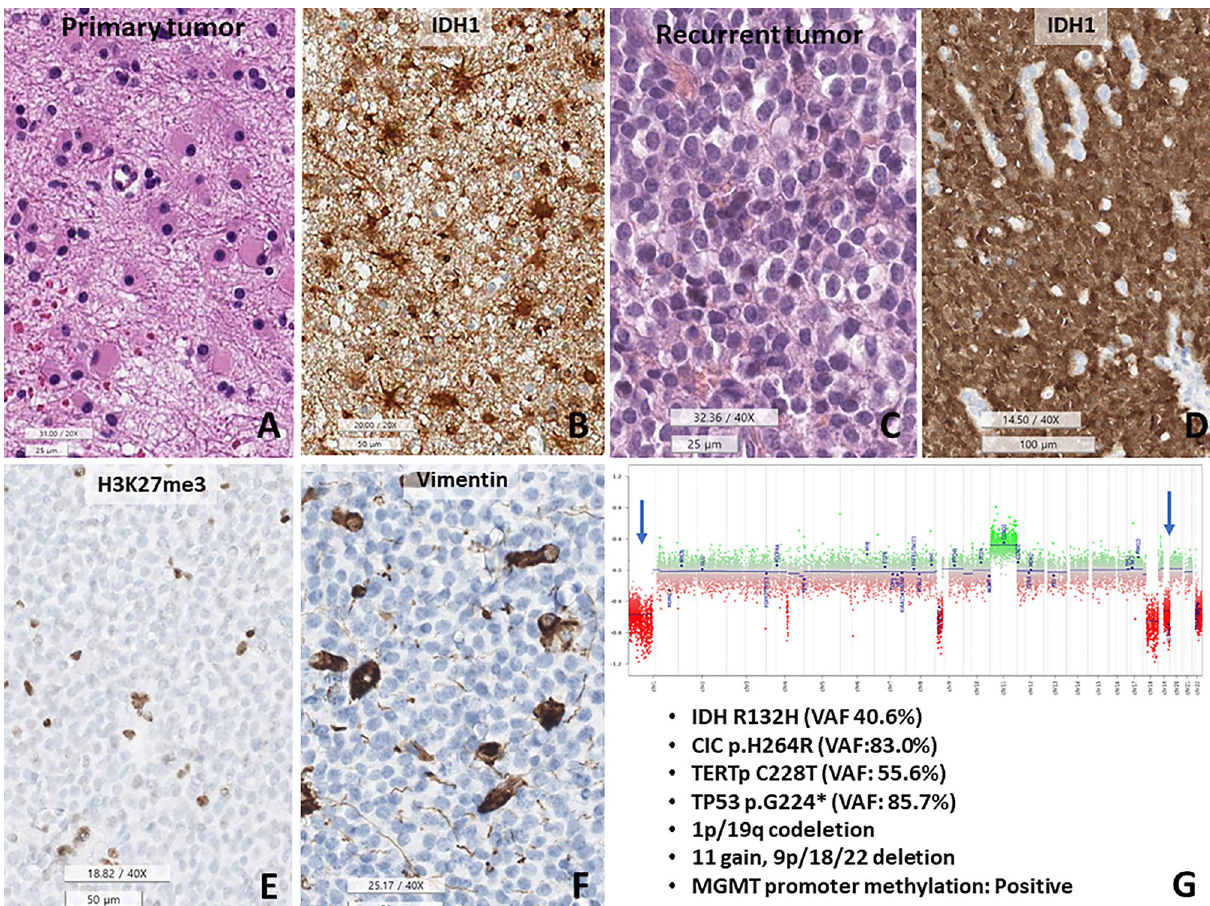
Figure 4. The 1p/19q-codeleted astrocytoma, IDH-mutant. This tumor recurred twice. ( A , B ) The initial tumor is a diffuse astrocytoma, IDH-mutant, consisting of hereditary astrocytes and IDH1-positive cells. ( C , D )